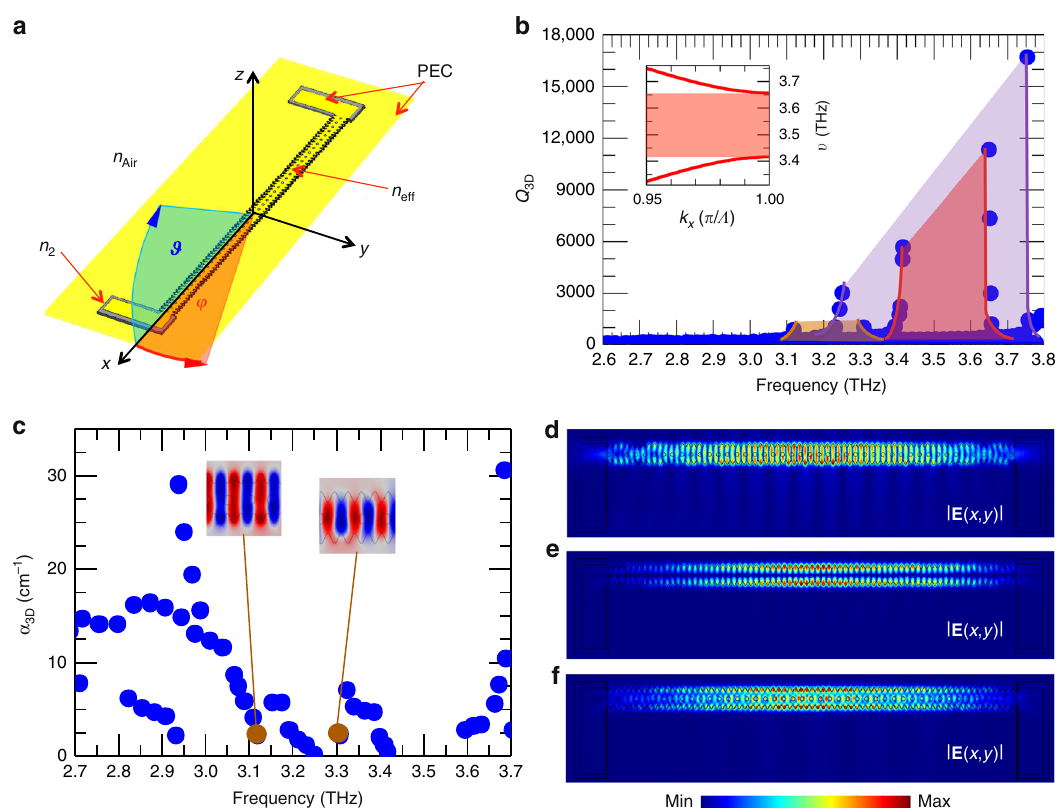
Fig. 2 Three-dimensional simulations. a Schematic diagrams of the simulation geometry. The bottom substrate and the top metallic surface were simulated as perfect electric conductors (PEC) to mimic the metal layers. The active material was described by the refractive index n eff = 3.50, the Cr pads with n 2 = 4.43 + 0.31 i , while the open boundaries outside the mesa were modeled with an external region of air ( n Air = 1), surrounded by appropriate scattering boundary conditions. According to the de fi ned reference system, the vertical and horizontal angles of emission are ϑ (blue shade), lying in the x – z plane, and φ (red shade), lying in the x – y plane. b Three-dimensional quality factors, Q 3D , computed at different eigenfrequencies for a sinusoidally corrugated resonator with a feedback periodicity Λ fb = 13.6 µ m, an average width of 40 µ m, and a corrugation amplitude of 10 µ m. The extraction hole pattern is neglected. The different photonic bandgaps associated with the fundamental mode (brown), the fi rst-order lateral mode (magenta), and the second-order lateral mode (red), are shown. Inset: computed bandgap of the second-order lateral mode. c Total losses α 3D plotted as a function of the resonant frequencies for a 40- µ m-wide wire cavity with η = 0.95, computed for a patterned surface array of circular air holes with periodicity Λ e = 22.4 µ m and radius r = 5 µ m. Insets: real part of the electric fi eld component E z ( x,y ) for the fundamental band-edge modes above and below the bandgap. Red (blue) indicates negative (positive) values of E z . d – f Spatial distributions of the normalized electric fi eld | E ( x,y )| of the lower-edge states at half height ( z = 5 µ m) of the sinusoidal wire laser cavity. d is the fundamental mode at ν = 3.12 THz, e is the fi rst-order lateral mode at ν = 3.25 THz, and f is the second-order lateral mode at ν = 3.42